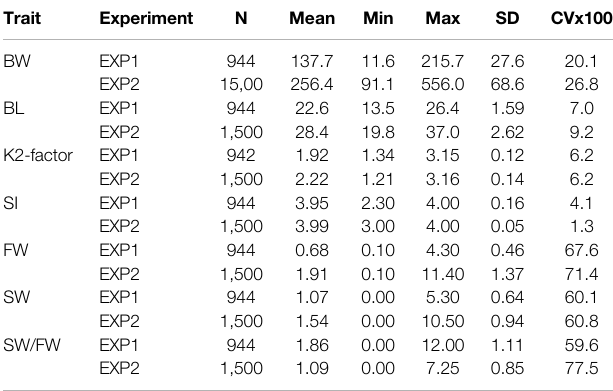
TABLE 2 | Descriptive statistics for body weight (BW), body length (BL), condition factor(K-factorandK2-factor),freshwatervariant(FW),seawatervariant(SW), SW/FW ratio, and smolt index (SI) recorded at the major sampling of the fi sh in EXP1 (sampling 6) and EXP2 (sampling 5). Trait Experiment